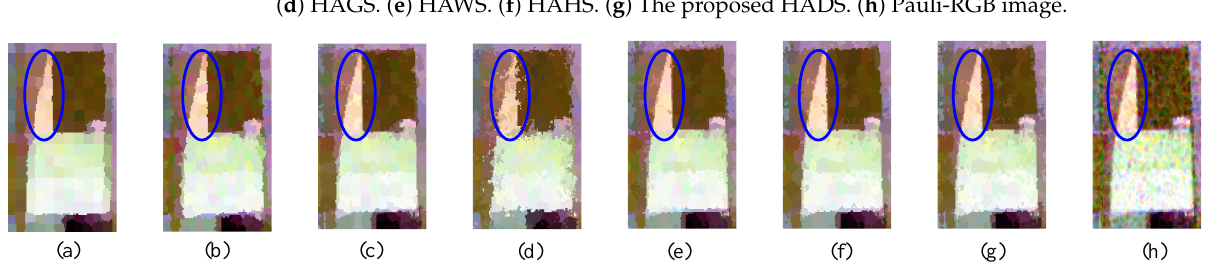
Figure 15. Enlarged results for region A of data set 1. ( a ) POL-SLIC. ( b ) POL-LSC. ( c ) POL-HLT. ( d ) HAGS. ( e ) HAWS. ( f ) HAHS. ( g ) The proposed HADS. ( h ) Pauli-RGB image.